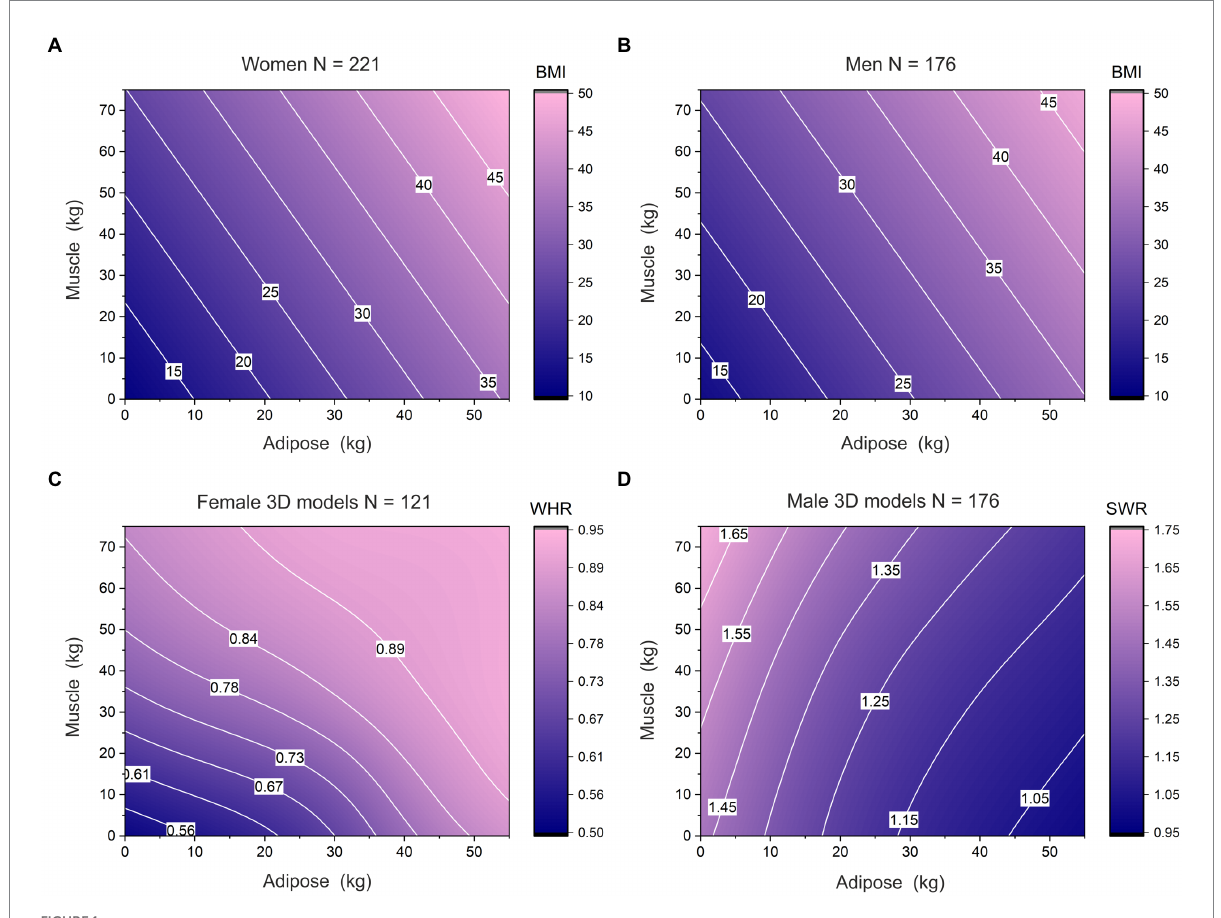
FIGURE 1 Contour plots showing the relationships between body composition (i.e., muscle mass on the y -axis and adipose mass on the x -axis) and BMI (a and b), WHR (C) , and SWR (D) . In each case, BMI increases from navy blue to pink. The isocontours, in white, show how varying combinations of muscle and adipose mass can give rise to the same BMI, WHR, or SWR values. The plots in the top row are derived from multiple regression models predicting BMI from muscle mass, adipose mass, and chronological age in 221 women (A) and 176 men (B) (see, Maalin et al., 2021). The plots in the bottom row are derived from direct measurement of the 3D stimuli used in this study: WHR for 121 female stimuli (c) and SWR for 121 male stimuli (d). In each case for (c) and (d) we calculated smoothed spline interpolations (Harder and Desmarais, 1972; Meinguet, 1979; Green and Silverman, 1994) using PROC MIXED in SAS v9.4 (SAS Institute, North Carolina, United